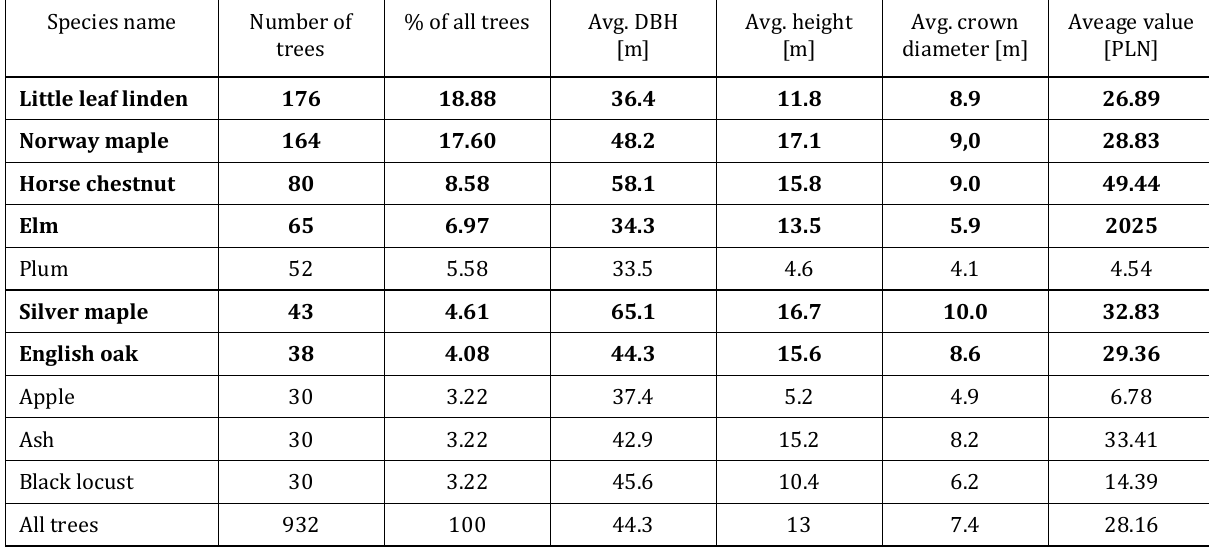
Fig. 4. Tree condition (source: author’s own elaboration based on the results of the i-Tree Eco model) Table 1. Structural characteristics of investigated stands (source: author’s own elaboration based on the results of the i-Tree Eco